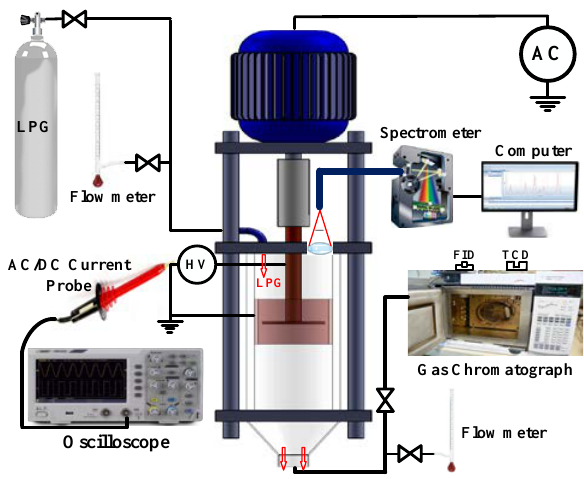
Figure 1. Scheme of the experimental setup.